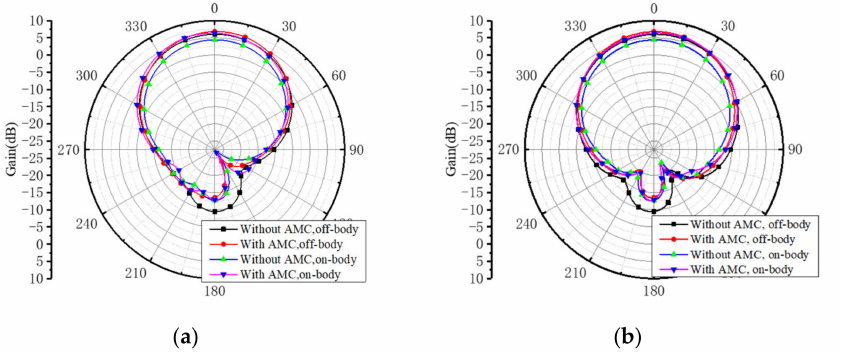
Figure 13. The simulated radiation patterns of the textile slotted microstrip antenna at 2.45 GHz: ( a ) E-plane, ( b )